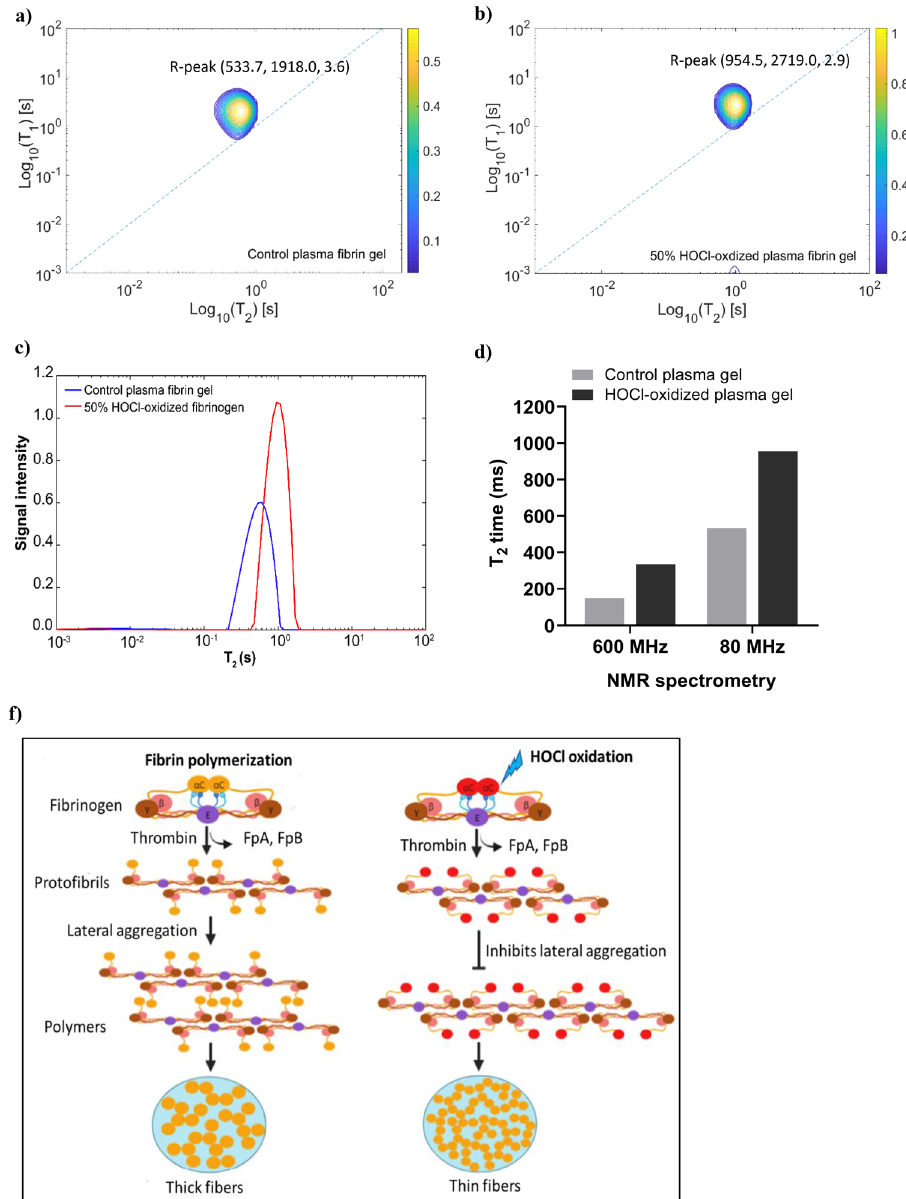
Figure 5. The T 2 /T 2 correlational spectra of control plasma fibrin gel and 50% HOCl-oxidized plasma fibrin gel measured by Bruker mq20 Minispec benchtop spectrometry operating at 80 MHz. ( a ) T 2 /T 2 correlational spectrum of control plasma fibrin gel. ( b ) T 2 /T 2 correlational spectrum of 50% HOCl-oxidized plasma fibrin gel (formed by added with 50% HOCl-oxidized fibrinogen prior to clotting). The T 1 /T 2 correlational spectrum was presented in the semilog-log plot. ( c ) T 2 distributions of water in the control plasma fibrin gel and 50% HOCl-oxidized plasma fibrin gel. ( d ) T 2 relaxation times of water protons in the control plasma fibrin gel and 50% HOCl-oxidized plasma fibrin gel were measured by both 80 MHz and 600 MHz NMR spectrometry. The 80 MHz spectrometry acquired eight scans for the signal averaging in each experiment, 36 data points collection time of 1 min echo time, and 6000 number of echoes. The 600 MHz spectrometer used a conventional CPMG and saturation inversion recovery pulse sequences. ( f ) The diagram illustrates the proposed mechanism of protofibrils lateral aggregation to form fibers in the plasma fibrin gels upon HOCl